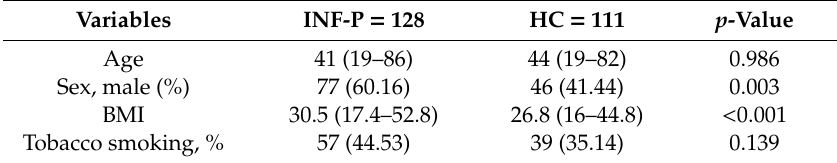
Table 1. Demographic and clinical data of the influenza A / H1N1 infection (INF-P) and healthy contact (HC) groups.